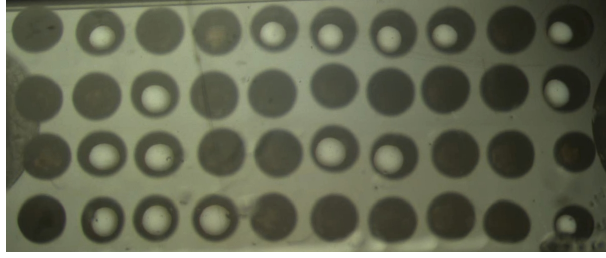
Figure 1. Top view image showing a matrix composed of 40 droplets with a mean size of d = 1 . 04mm (wetted substrate area).